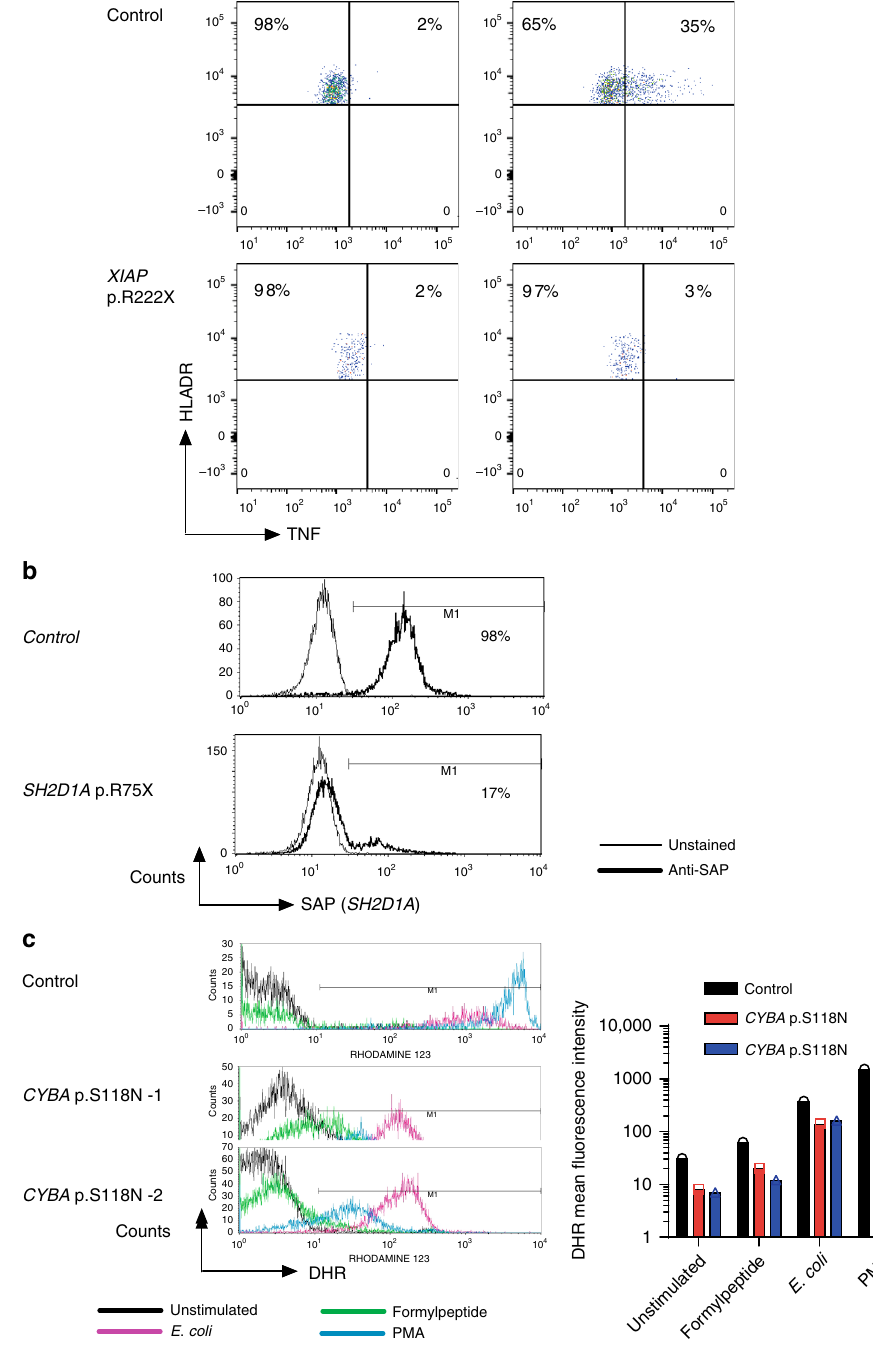
Fig. 2 Functional validation of pathogenic variants identi fi ed in monogenic IBD genes. a Defective MDP response in a patient with hemizygous XIAP p. R222X. MDP (muramyl dipeptide) induced intracellular TNF response was determined using FACS. b Absent SAP staining (gene product of SH2D1A ) as indicated by C-terminal antibody in a patient with hemizygous SH2D1A p.R75X. Measured with fl uorescence-activated cell sorting (FACS). c Defecting ROS production in neutrophils from patients with homozygous CYBA p.S118N variants. Dihydrorhodamine-1,2,3 (DHR) fl ow cytometry assay (FACS) was performed to measure NADPH oxidase activity in response to PMA, E. coli particles and